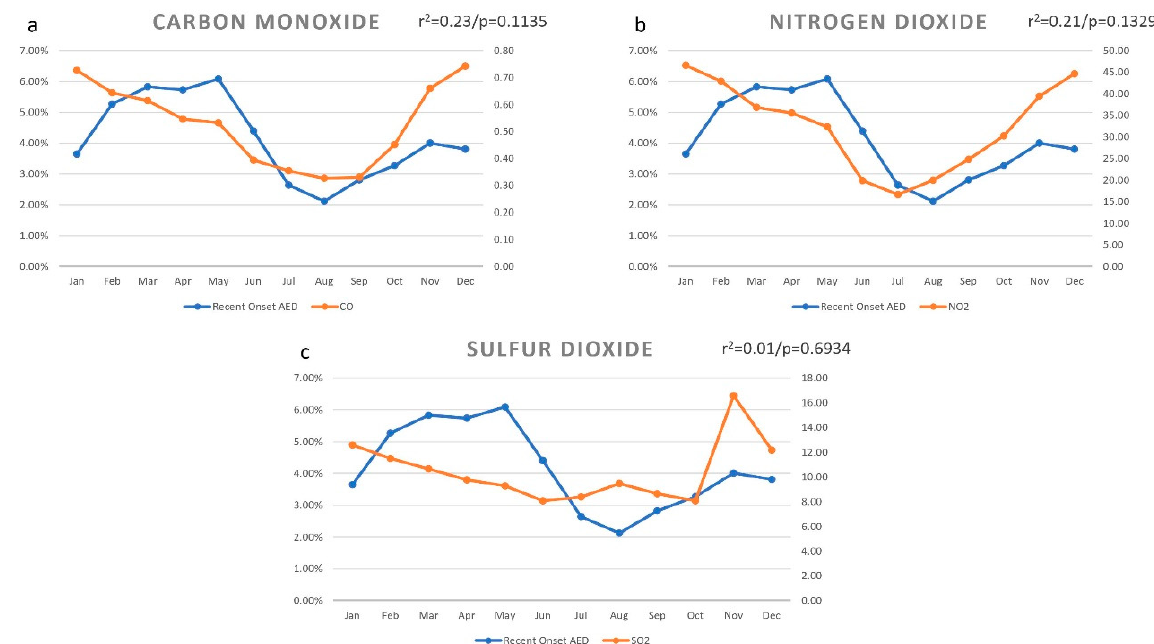
Figure 4. Monthly variation of air pollution indicators and the prevalence of recent onset allergic eye disease (AED) in the district of Hyderabad. The month-wise prevalence of AED was positively correlated with the distribution of carbon monoxide (( a ) r = 0.4809), nitrogen dioxide (( b ) r = 0.4595), and sulfur dioxide (( c ) r = 0.1273), and all were not statistically significant.